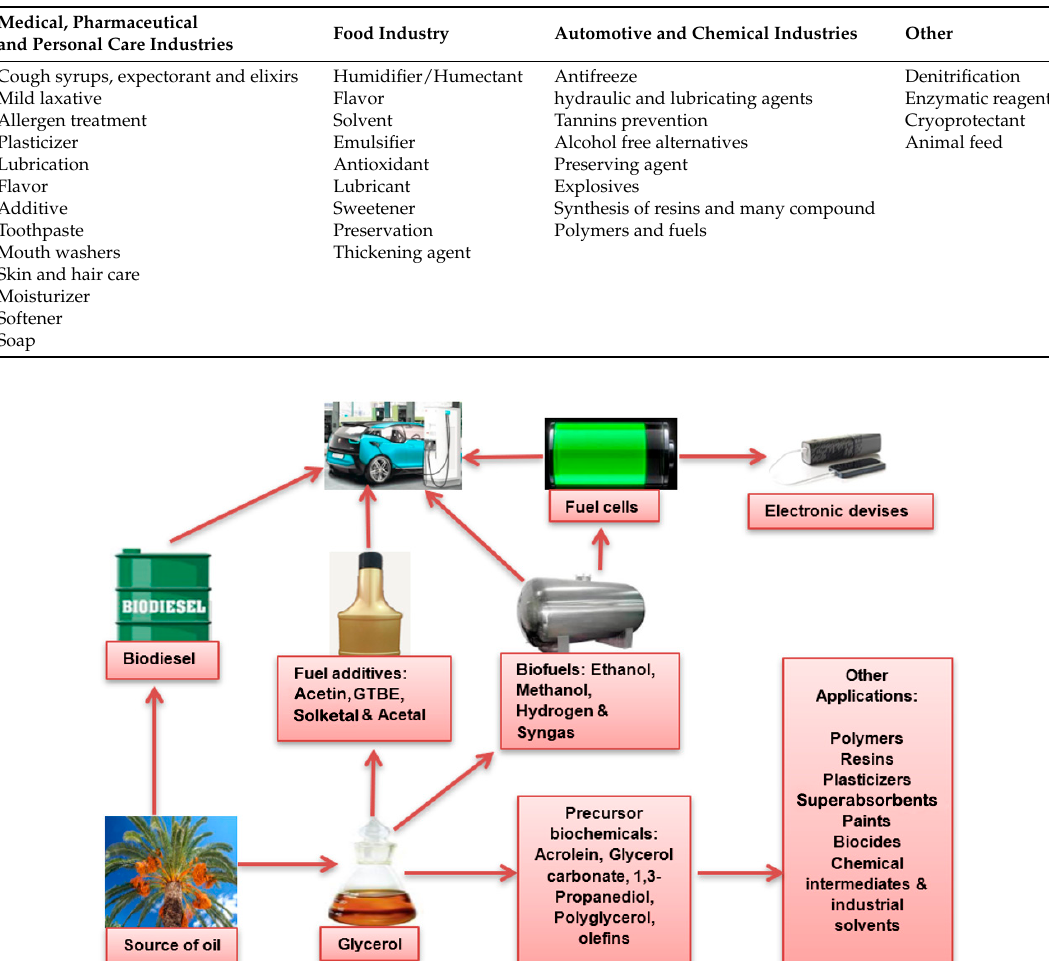
Table 1. Industrial applications of glycerol [31,35,41].